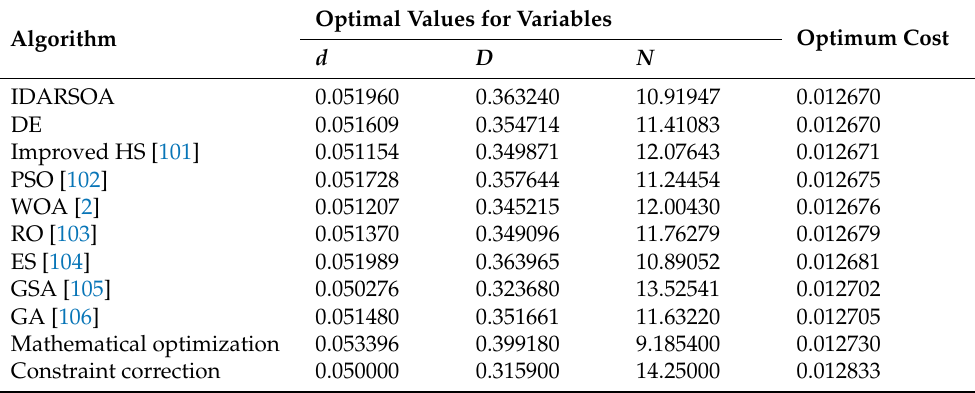
Table 11. Comparison results of the tension-compression string